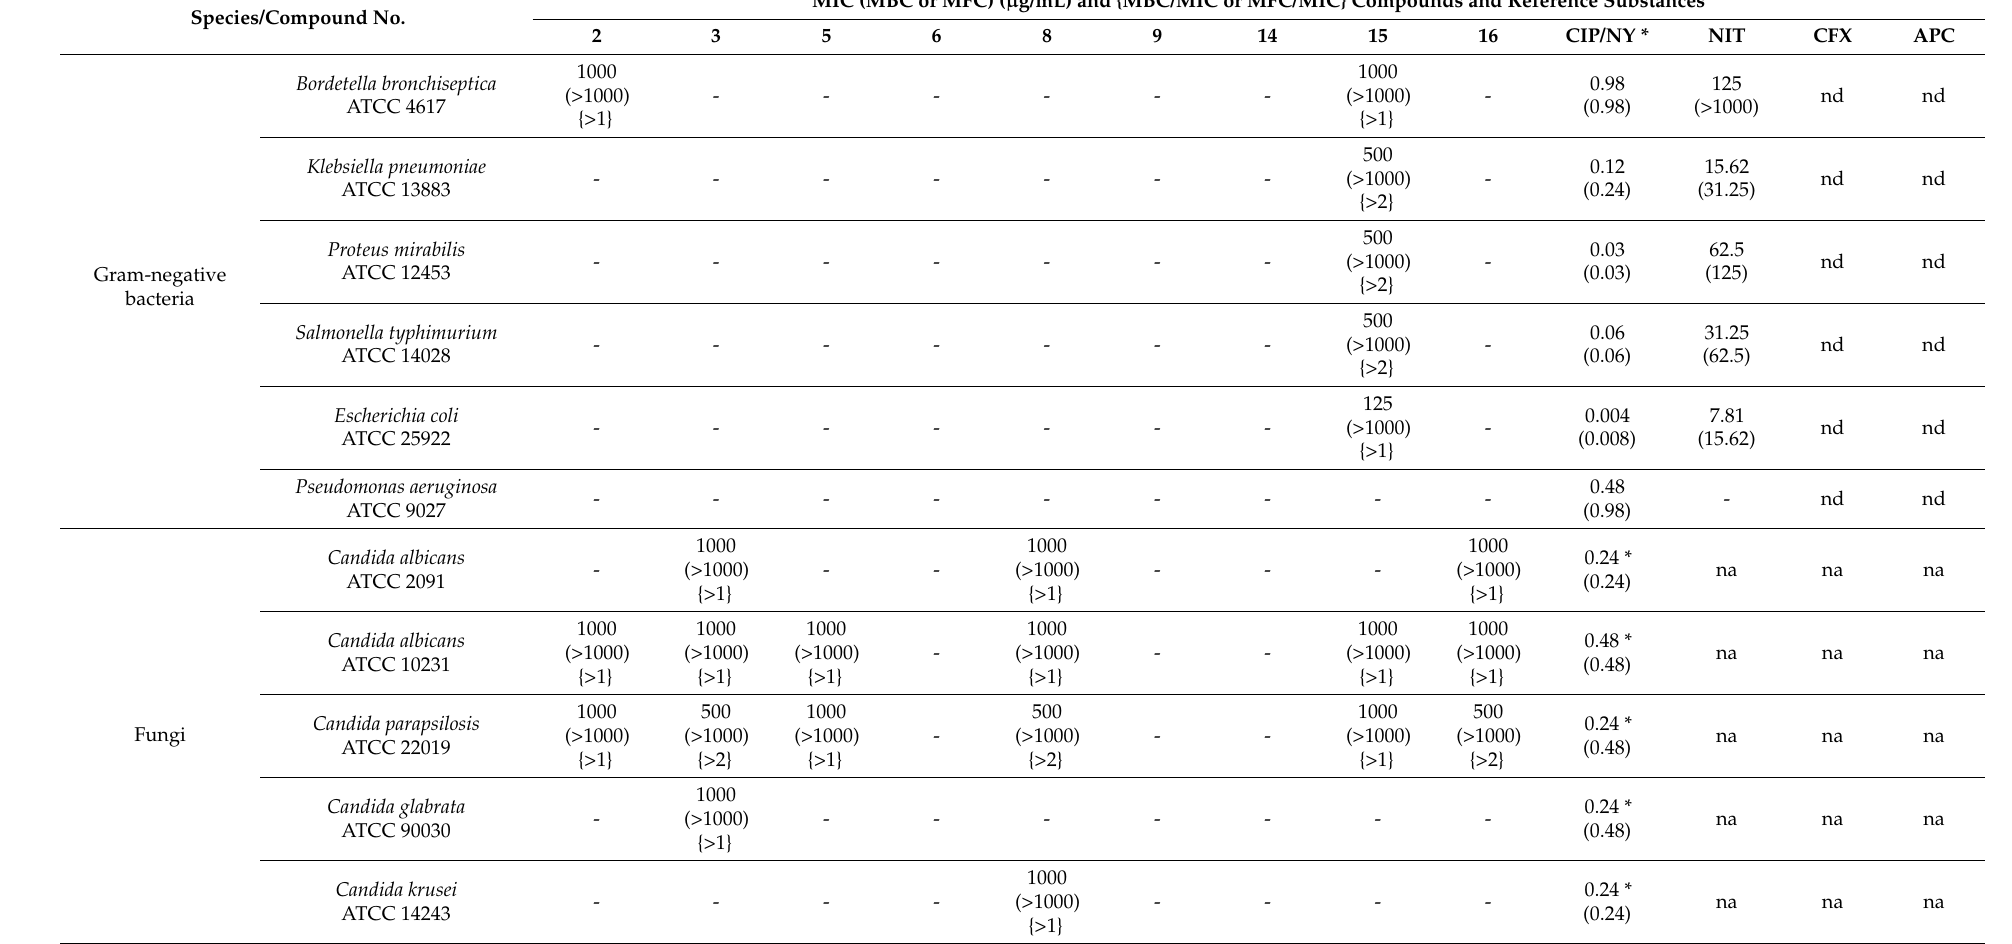
Species/Compound